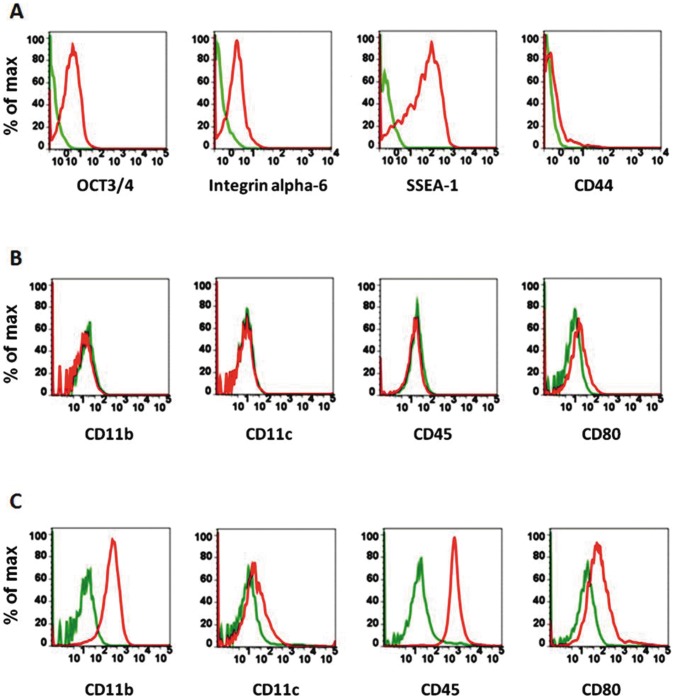
The nature of un-differentiated or differentiated cells was tested by flow cytometry.Flow cytometry on ESCs and ESDCs was used to monitor the expression of different cell surface markers. (A) Stem cell pluripotency markers on undifferentiated ESCs and (B) Dendritic cell markers on undifferentiated ESCs confirm their pluripotency and self-renewal nature; (C) Dendritic cell markers expressed on ESDCs confirm the change in APC. Green lines represent cells stained with control isotype, red lines are cells stained with the relevant antibody.